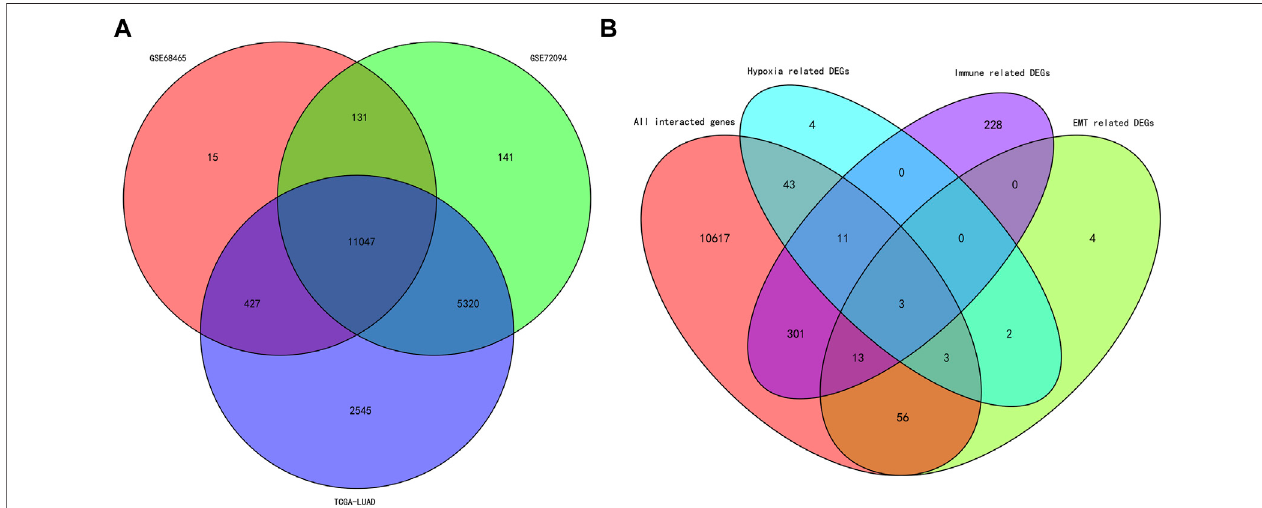
FIGURE4| VenndiagramoftheintersectedgenesandDEGs. (A) VenndiagramoftheintersectedgenesamongthecohortsofTCGA,GSE68465andGSE72094. (B) Venn diagram of the intersected hypoxia, immune and EMT related DEGs.